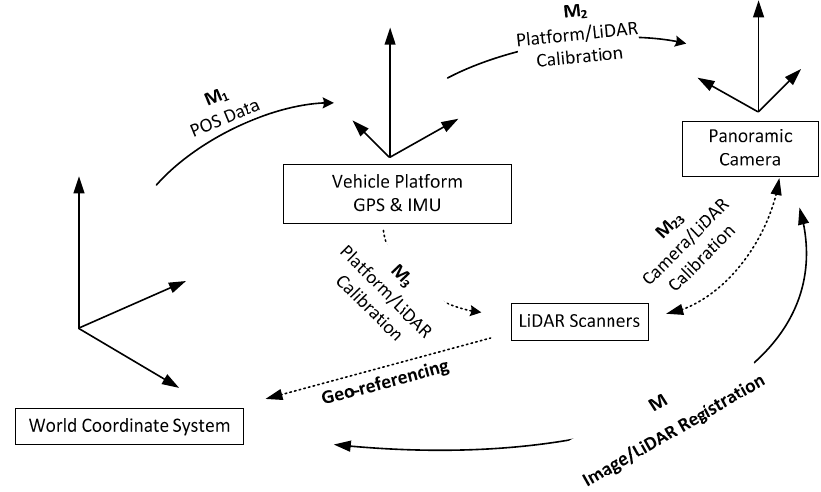
Figure 2. Coordinate systems of the Mobile Mapping System.